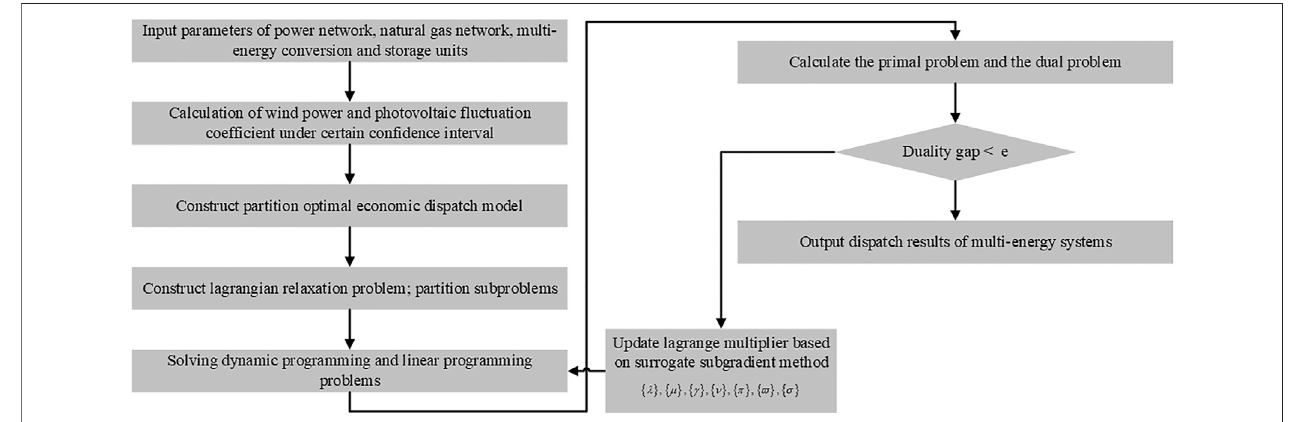
FIGURE 2 | The solving process of the locational marginal price-based partition optimal economic dispatch model of multi-energy system.